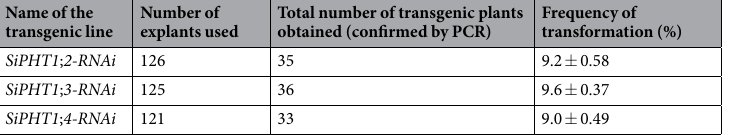
Table 2. Details of transgenic plants obtained and frequency of transformation for each RNAi line. For each treatment, three replicates were maintained. Values are expressed as the mean ±